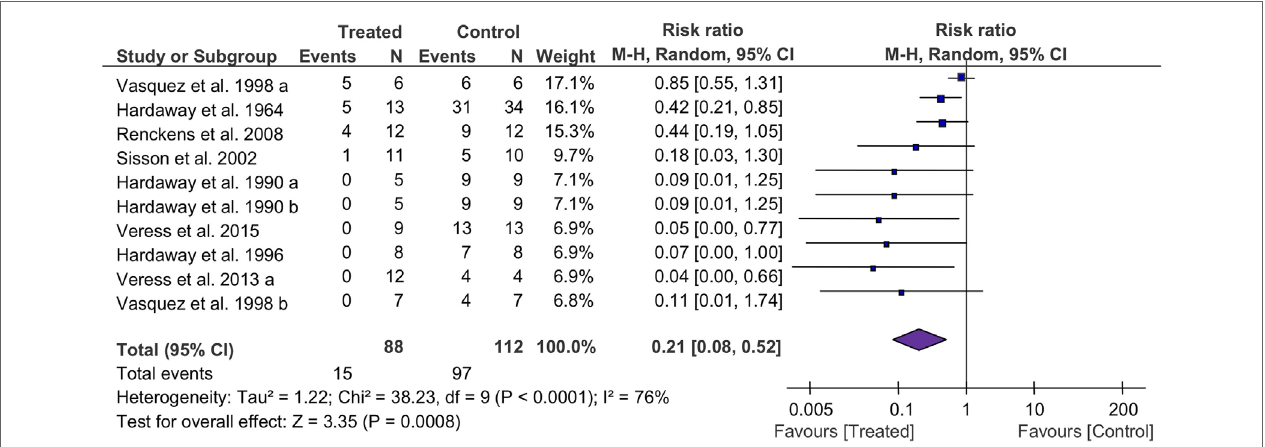
FiGURe 2 | Forest plot summarizing the effect of fibrinolytic therapy on overall mortality of acute lung injury animals. Squares and their sizes represent the risk ratio (RR) and corresponding contributions to overall effect (diamond), respectively. Horizontal lines through each square represent 95% confidence intervals (95% CI). I 2 depicts